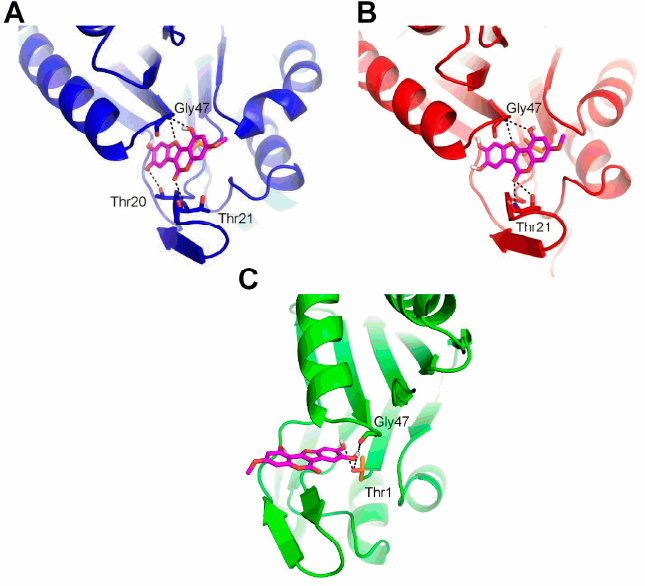
Figure 6. The binding modes of wedelolactone in the β 1 ( A ), β 2 ( B ), and β 5 ( C ) subunits of the yeast 20S proteasome. Wedelolactone is represented as magenta sticks, β 1, β 2, and β 5 subunits are represented as blue, red, and green, respectively. Dashed lines represent the specific H-bonds to the active sites residues. The catalytic residue Thr1 is represented as orange sticks.